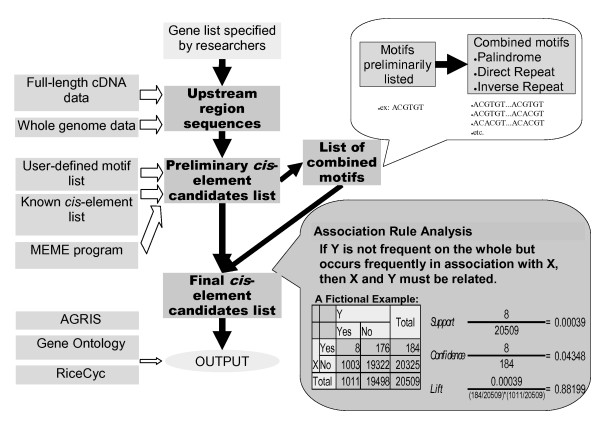
Features of RiCES.